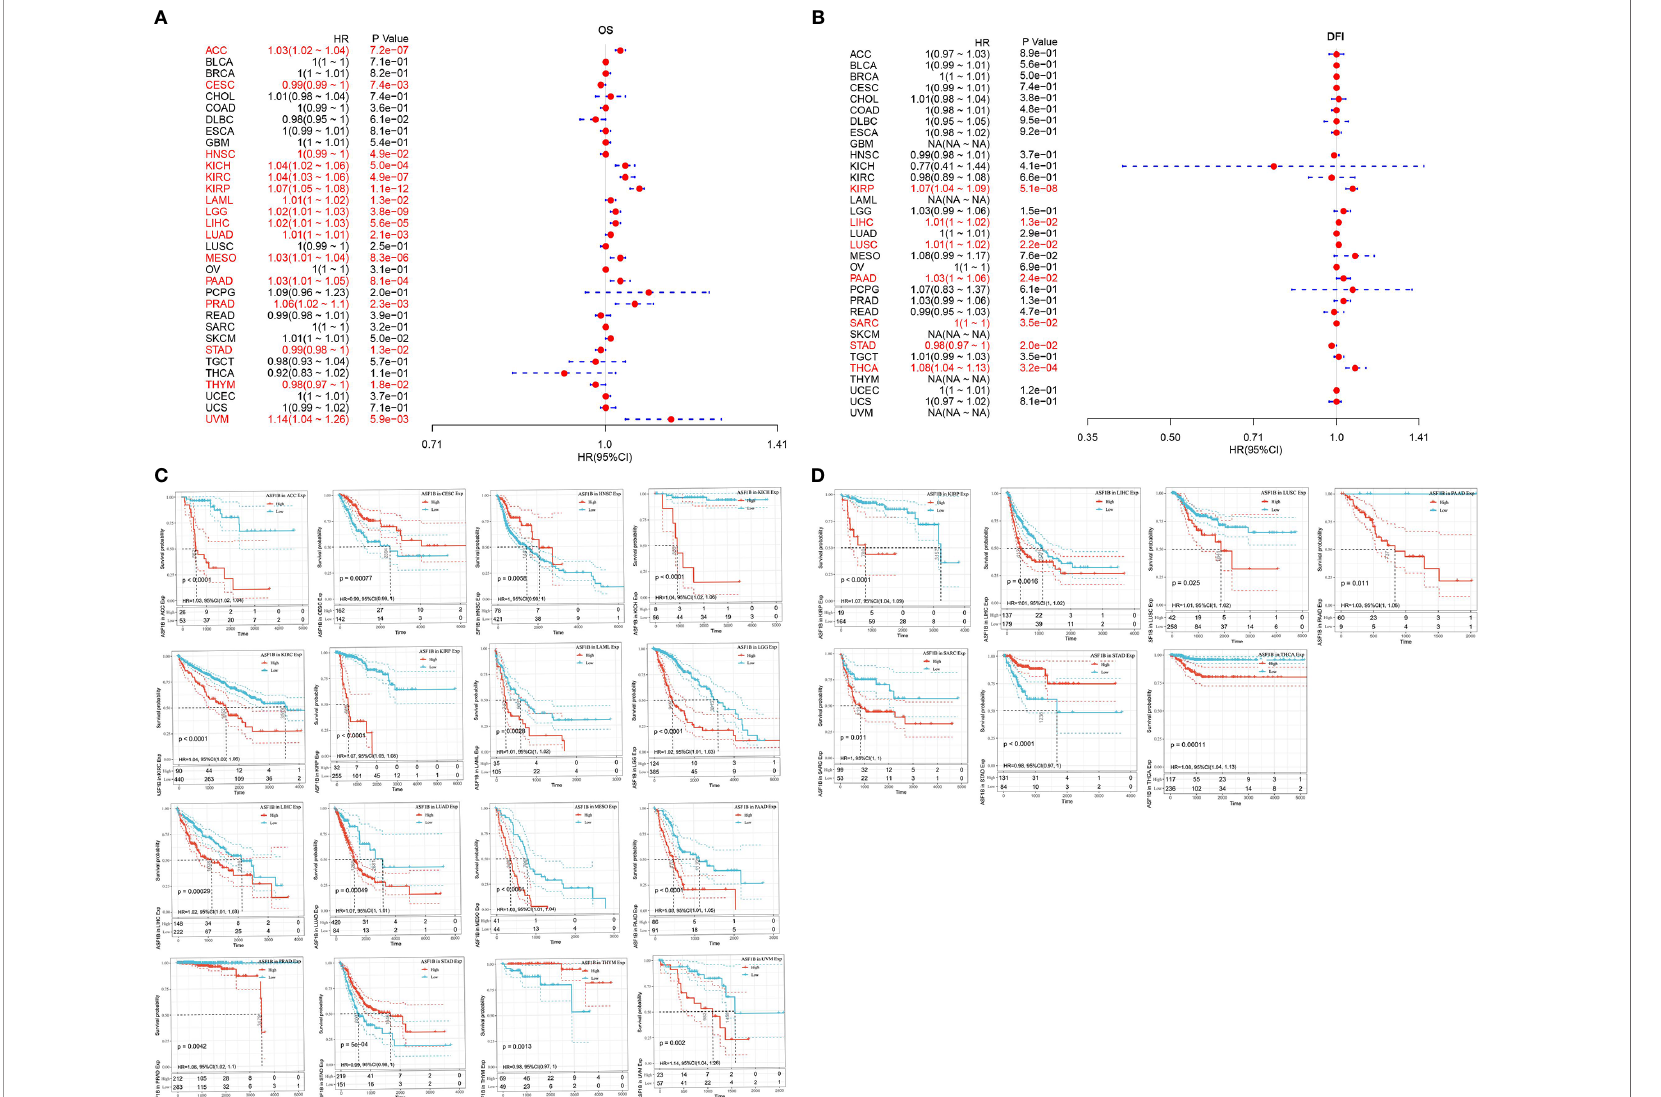
FIGURE 4 | Univariate survival analysis was used to analyze the relationship between ASF1B expression and survival time in 33 tumors; (A) forest plot showing the relationship between ASF1B expression and OS; (B) forest plot showing the relationship between ASF1B expression and DFS; (C) KM curves of high and low ASF1B expression in 16 tumors signi fi cantly associated with OS survival; (D) KM curves of high and low ASF1B expression in 7 tumors signi fi cantly associated with